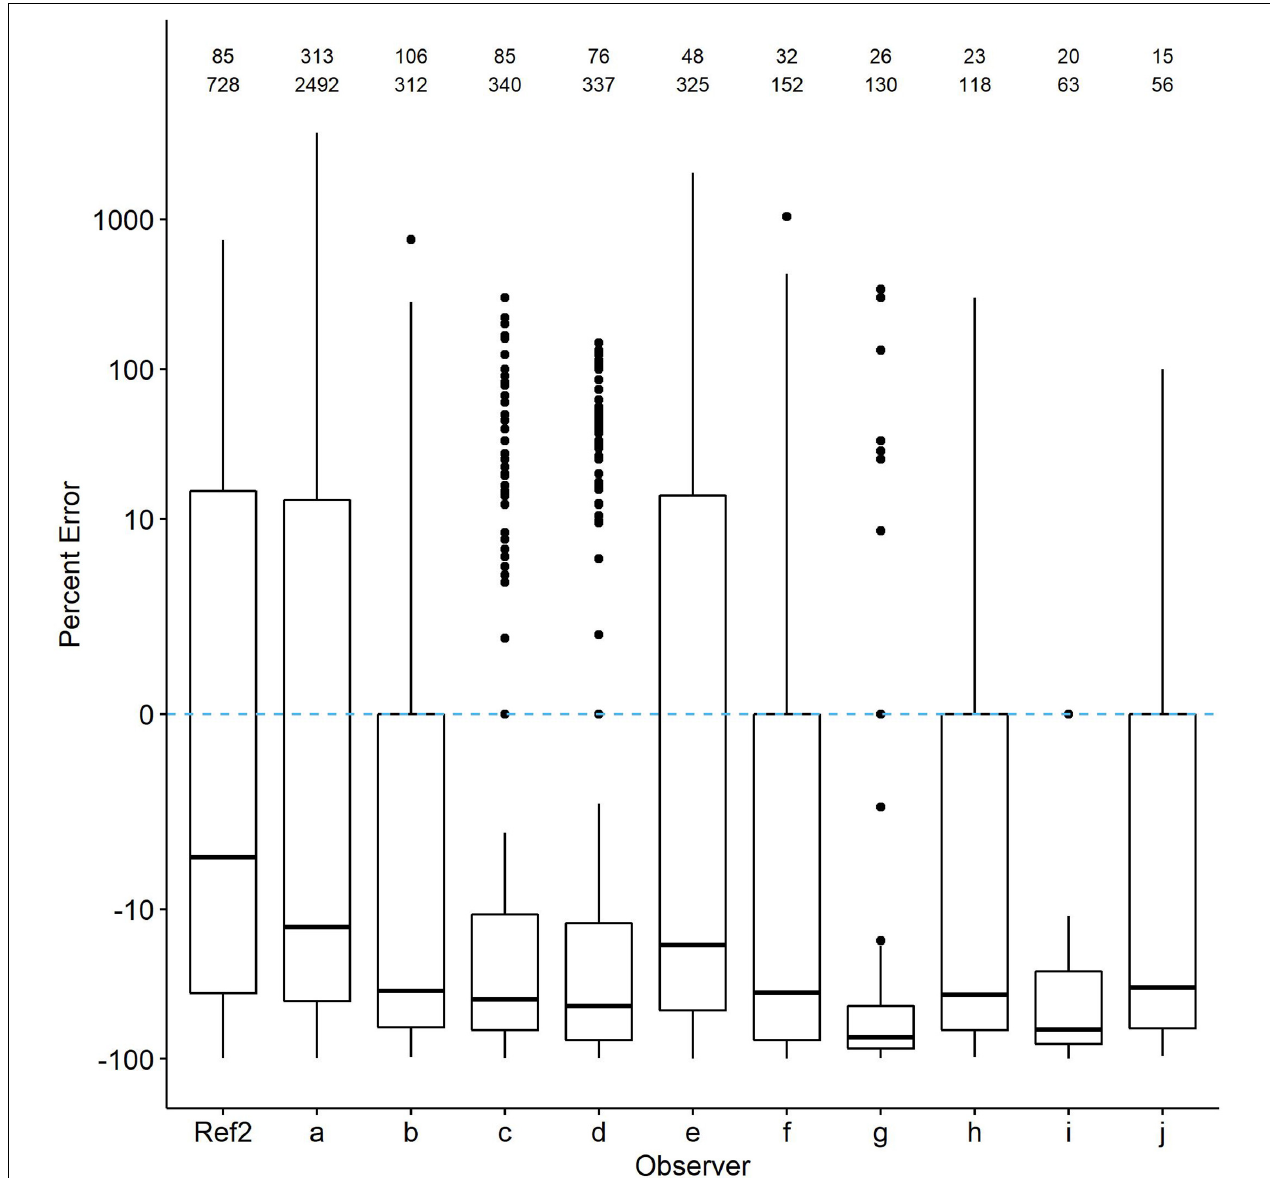
FIGURE 5 | Comparison of percent count errors in eBird checklists contributed by the 10 observers with the most checklists (top row of numbers) and waterbird observations (second row of numbers; each checklist includes multiple species). The zero line is R* . Ref2 is the second-visit data from WDR. Quantile plots show the median, 25th percentiles as boxes and whiskers, plus outliers. Species-specific plots are available from the authors upon